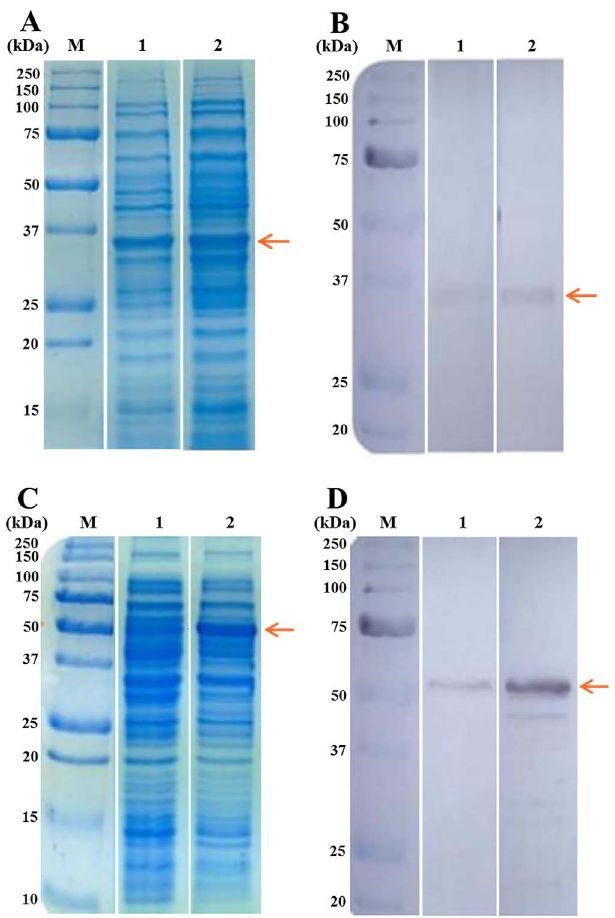
Figure 2. Recombinant proteins expression. A. SDS-PAGE analysis of protein fractions from E. coli cultures for rGluCl expression. M = Molecular weight marker. 1 = Uninduced and 2 = Induced culture with IPTG. B. Western blot analysis of rGluCl. M = Molecular weight marker. 1 = Uninduced and 2 = Induced culture with IPTG. C. SDS-PAGE analysis of protein fractions from E. coli cultures for rGlyR expression. M = Molecular weight marker. 1 = Uninduced and 2 = Induced culture with IPTG. D. Western blot analysis of rGlyR. M = Molecular weight marker. 1 = Uninduced and 2 = Induced culture with IPTG. In all cases, the molecular weight marker used was the Precision Plus Protein All Blue Prestained Protein Standard from Bio-Rad. Arrows indicate the size of the recombinant proteins.